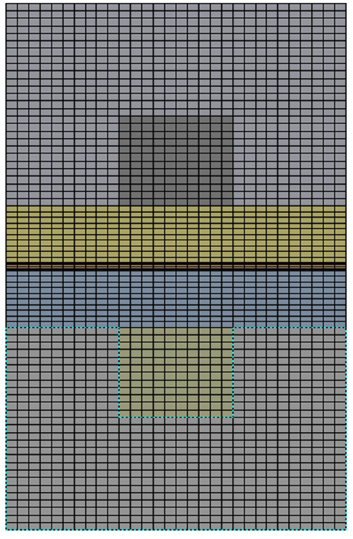
Figure 2. The Grid Elements of single channel model.